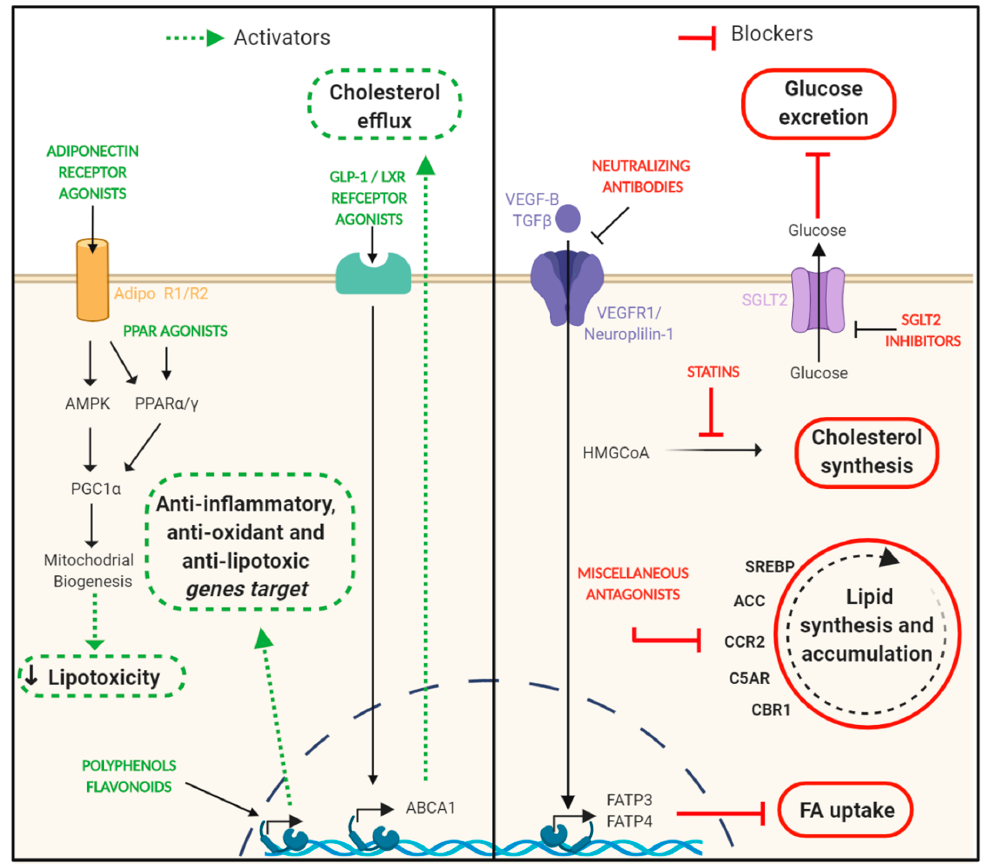
Figure 3. Targeting lipotoxicity in DN. The intrarenal lipids reduction has been positively correlated